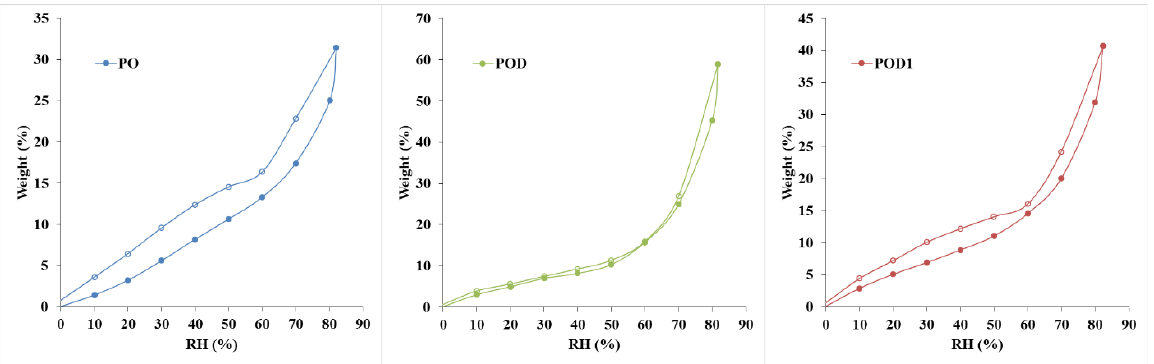
Figure 6. Water adsorption isotherm curves (with full circles) and hysteresis cycles (desorption curves with empty circles) plotted for the oxidized pullulan – dopamine hydrogels.